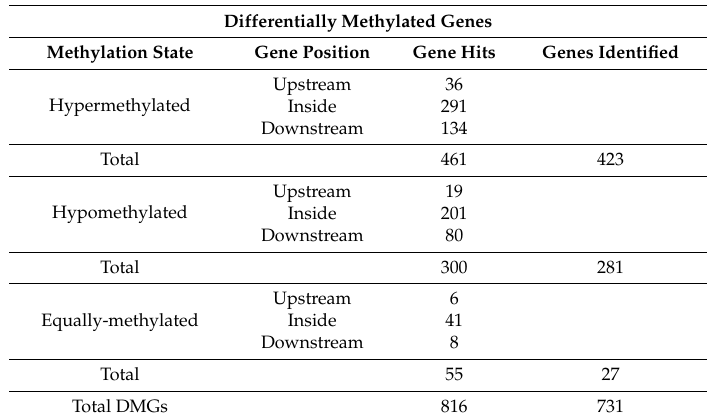
Table 2. The number of differentially methylated genes (DMGs) identified from sequenced fragments mapping onto the Prunus persica genome